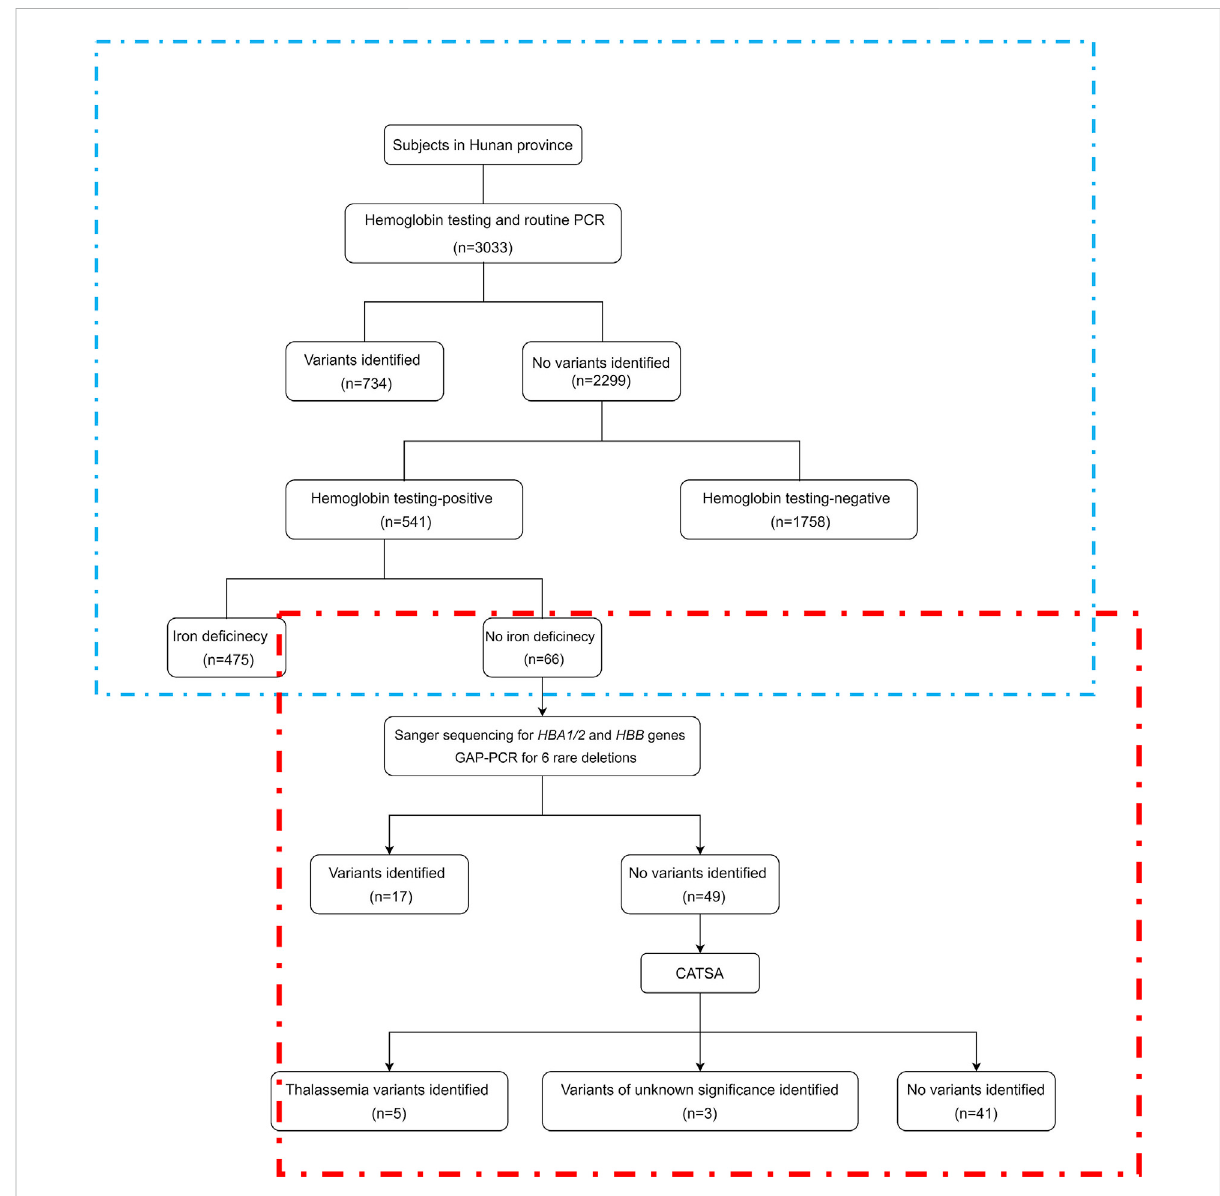
FIGURE 2 Study fl owchart. CATSA, a third-generation sequencing approach termed comprehensive analysis of thalassemia alleles. PCR, polymerase chain reaction. The part in the blue box is the retrospective analysis, and the part in the red box is the study fl